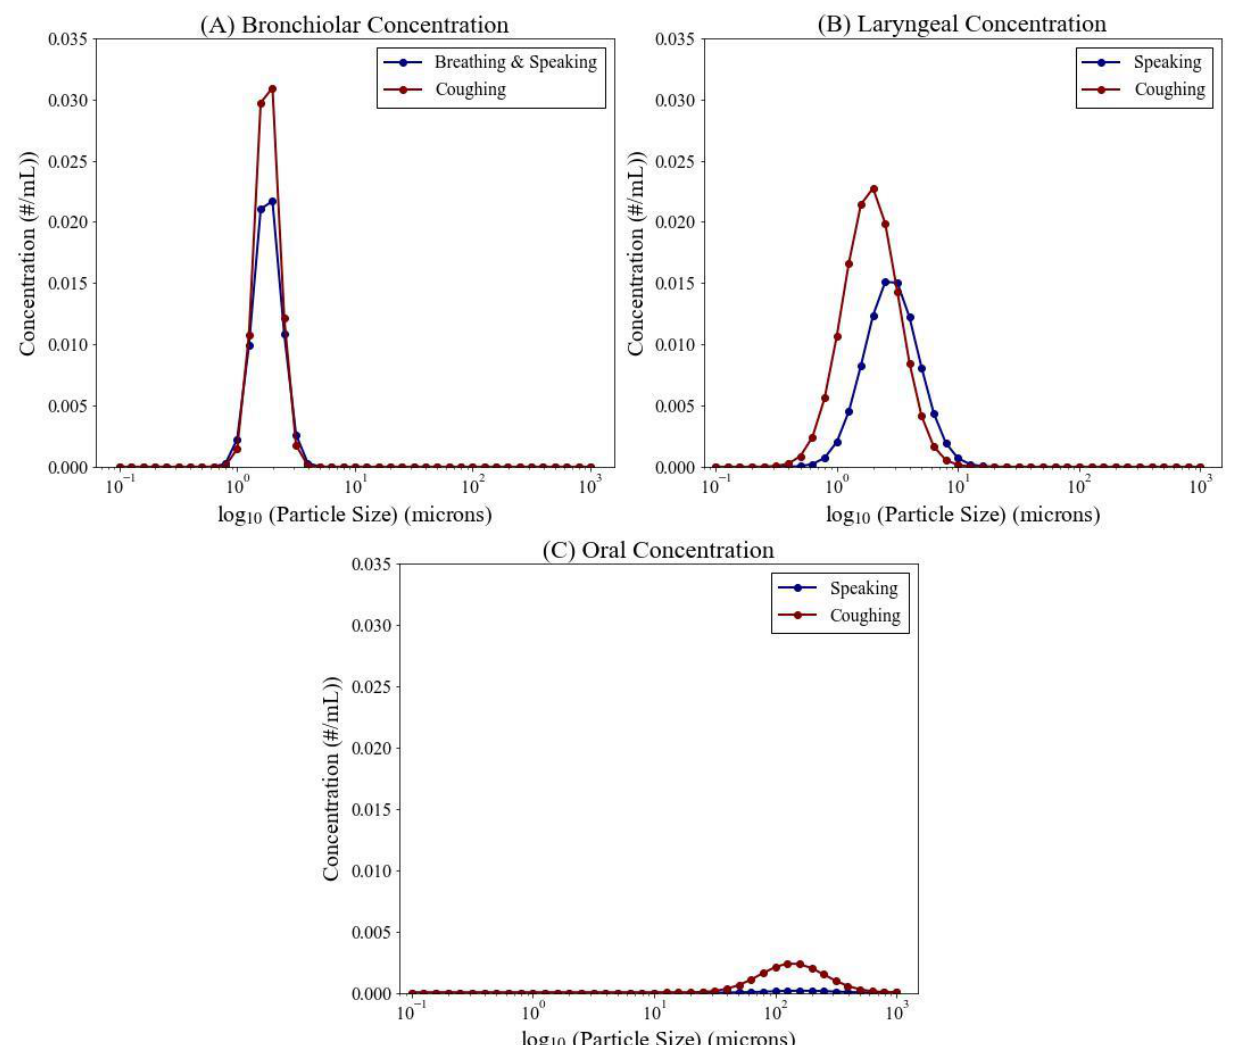
Figure 2. Particle concentrations versus particle size for different emission mechanisms (breathing, speaking, and coughing). Subplots ( A – C ) describe the concentrations emitted from the bronchio- lar, laryngeal, and oral regions,